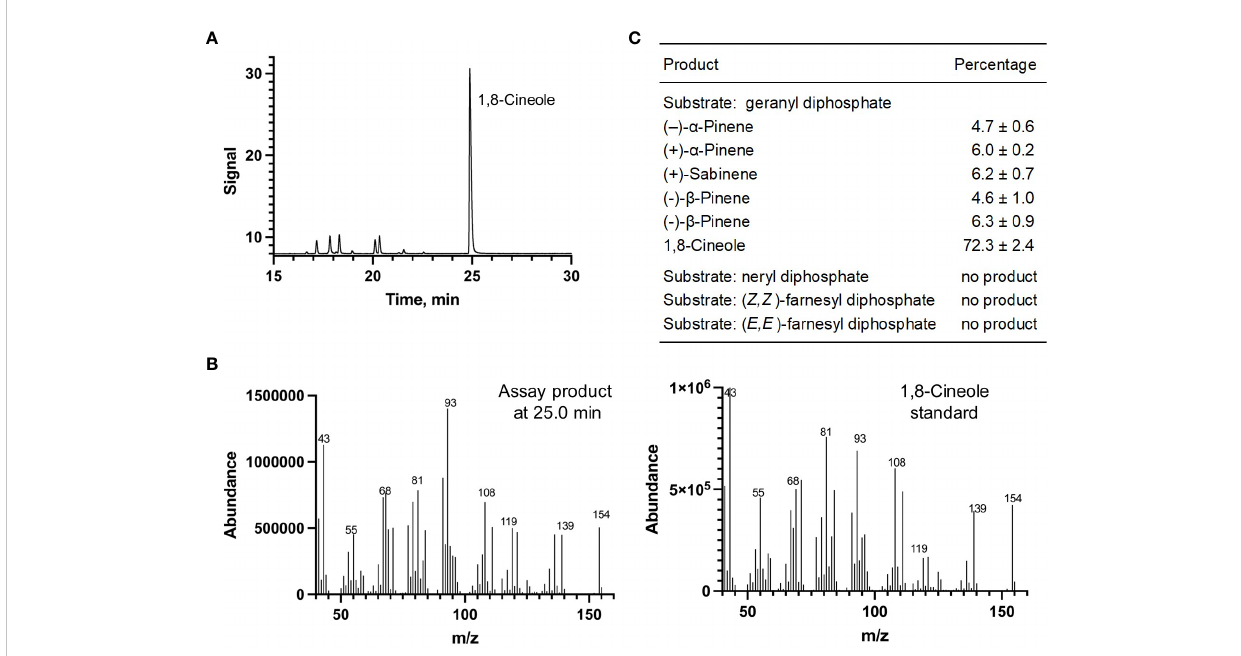
FIGURE 8 Characterization of M. longifolia CMEN 585 candidate Mp_12413. (A) GC chromatogram with annotation for major peaks; (B) mass spectrum of the main enzymatically generated product and the matching authentic standard (1,8-cineole); and (C) tabulated product pro fi